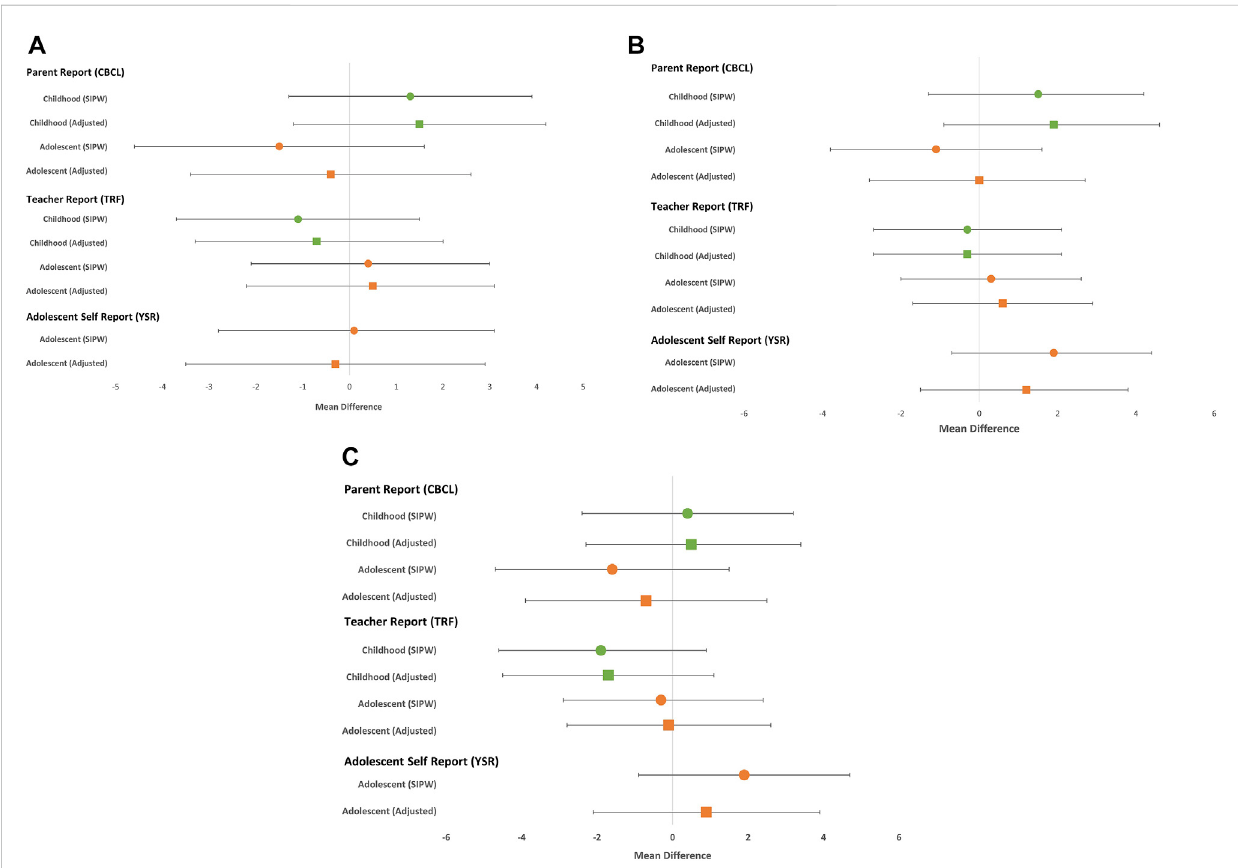
FIGURE 2 Mean differences and 95% con fi dence for internalizing (A) externalizing (B) and total (C) behavior problems comparing prenatal exposure to acetaminophen to no prenatal